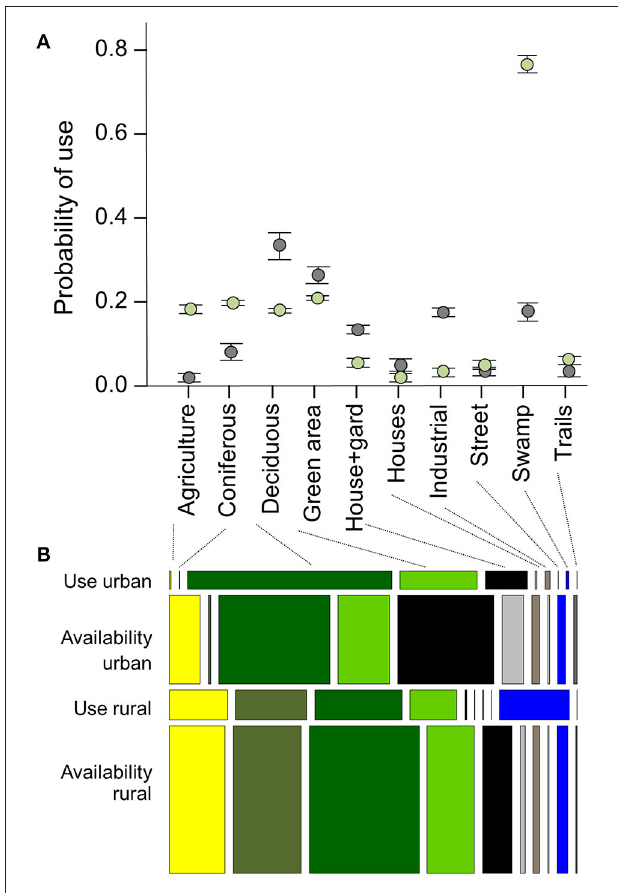
FIGURE 2 | Use vs. availability of selected habitats in urban and rural wild boar from Berlin and Brandenburg between 2013 and 2015. (A) Effect plot of the generalized linear mixed models (GLMM; details see main text), showing the probability of use of the different habitat classes for urban (gray dots) vs. rural (green dots) wild boar. The default cutoff is 0.17 because we used five times more correlated random walks than wild boar locations. (B) Percentage of locations within a habitat category among urban and rural wild boar (original track locations = use) and correlated random walks (CRW = availability) are displayed. The width of each box shows the composition of habitat classes within one of the four groups, the height represents the total amount of locations. Since there were five times more CRW location than wild boar locations, the boxes are higher for the